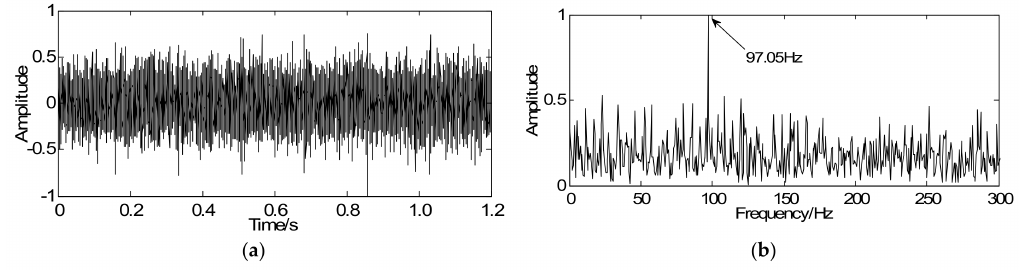
Figure 11. Gearbox signals: ( a ) time-domain signal with tooth-broken fault and ( b ) envelope spectrum of the time-domain